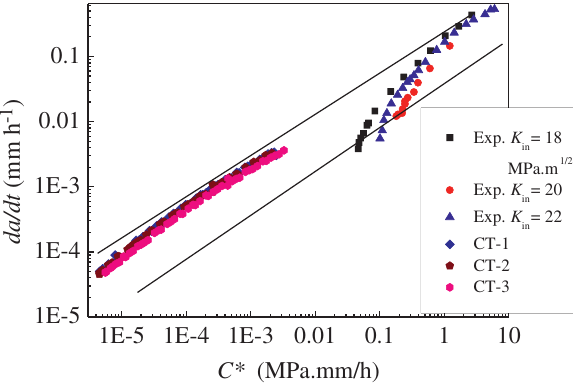
Figure 4: A comparison of the simulated da / dt – C* curves with the experimental date at different initial stress intensity factor K in in the literature [38] for C(T)